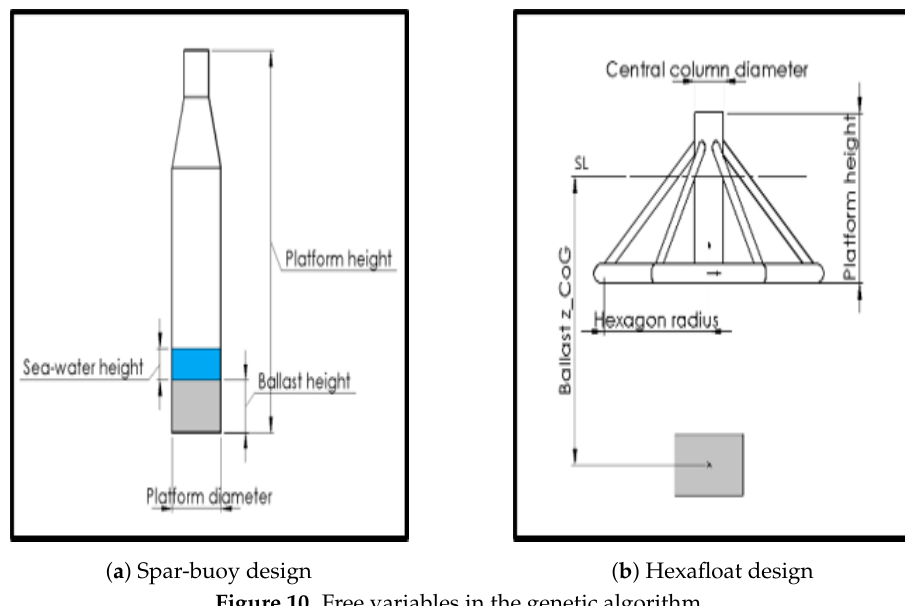
Figure 10. Free variables in the genetic algorithm.